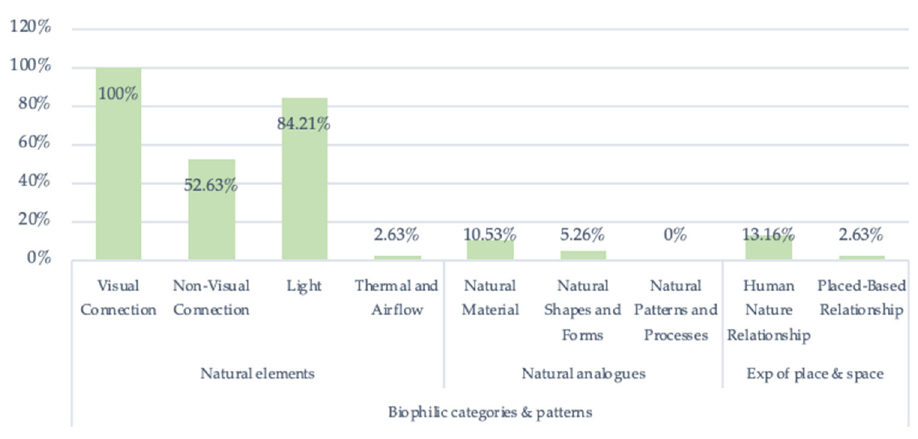
Figure 2. Distribution of the reviewed studies employing virtual natural environment based on biological responses and collected